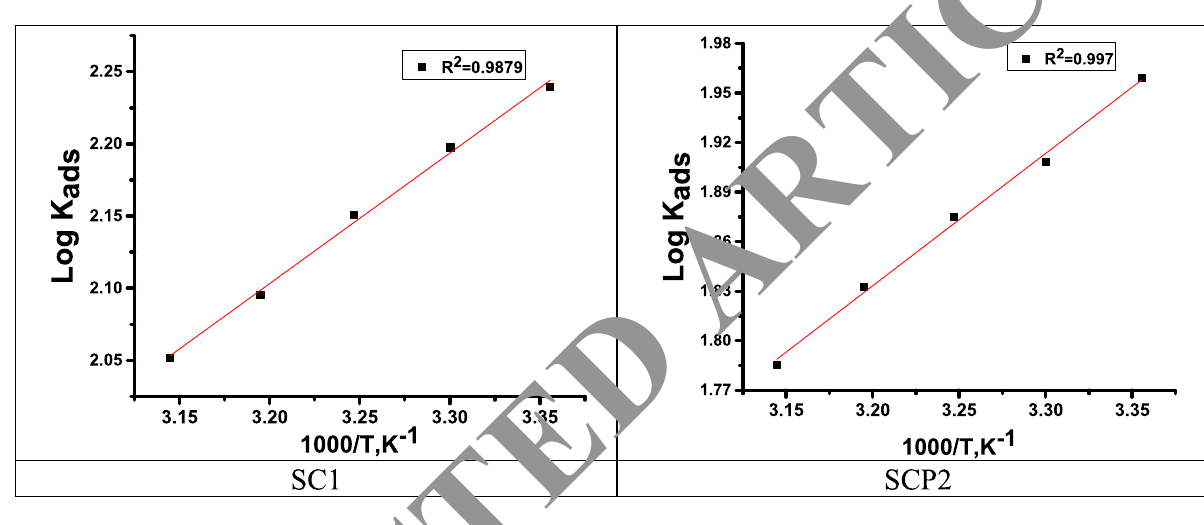
Figure 7. Log K ads versus T diagrams obtained from Langmuir adsorption isotherm for SC1 & SCP2.